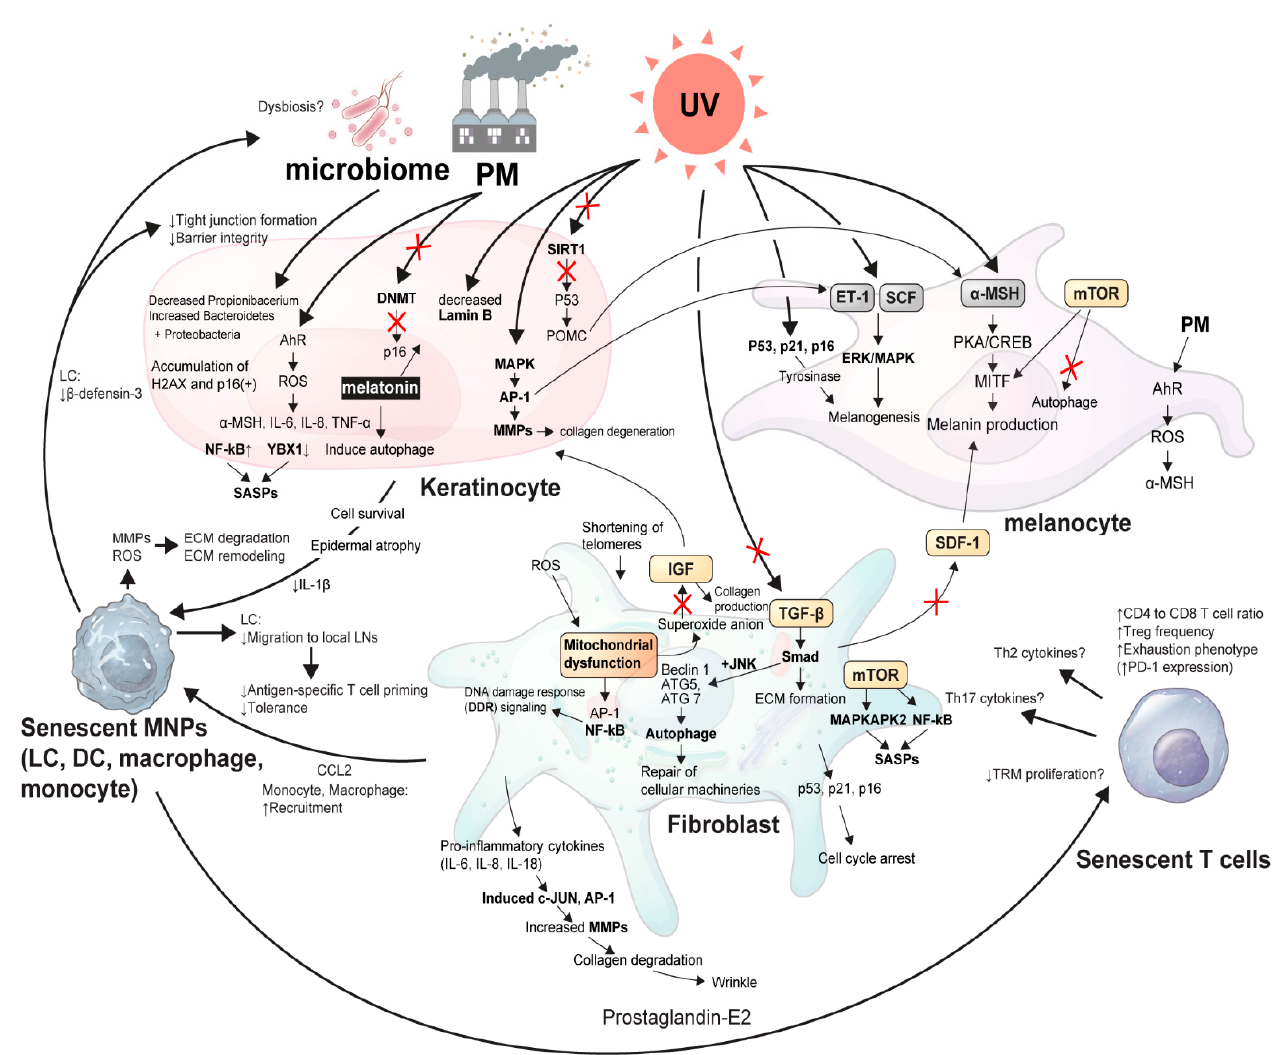
Figure 1. The schematic view of cellular cross-talk between skin microenvironment and inflammaging. An illustrative overview of the article showing the delicate signaling pathways from senescent skin microenvironments in association with external stressors, such as UVR, microbiome, and PM. α -MSH, α -melanocyte stimulating hormone; AhR, Aryl hydrocarbon receptor; AP-1, Activator protein 1; ATG, Autophagy related; CCL2, C-C motif chemokine ligand 2; CREB, Cyclic AMP-responsive element-binding protein; DCs, Dendritic cells; DNMT, DNA methyltransferase; ECM, Extracellular matrix; ERK, Extracellular signal-regulated kinase; ET, Endothelin; H2AX, H2A histone family member X; IGF, Insulin-like growth factor; IL, Interleukin; JNK, c-Jun N-terminal kinase; LCs, Langerhans cells; LN, Lymph node; MAPKAPK2, MAP kinase Activated Protein Kinase 2; MAPKs, Mitogen-activated protein kinases; MITF, Microphthalmia-associated transcription factor; MMPs, Matrix metalloproteinases; MNPs, Mononuclear phagocytes; mTOR, Mammalian target of rapamycin; NF- κ B, Nuclear factor kappa-light-chain-enhancer of activated B cells; PD-1, Programmed cell death protein 1; PKA, Protein kinase A; PM, Particulate matter; POMC, Pro-opiomelanocortin; ROS, Reactive oxygen species; SASP, Senescence-associate secretory phenotype; SCF, Stem cell factor; SDF-1, Stromal cell-derived factor-1; TGF, Tumor growth factor; Th cells, T helper cells; TNF- α , Tumor necrosis factor- α ; TRM, Tissue-resident memory T cell; UV, Ultraviolet light; YBX-1, Y-Box Binding Protein 1.